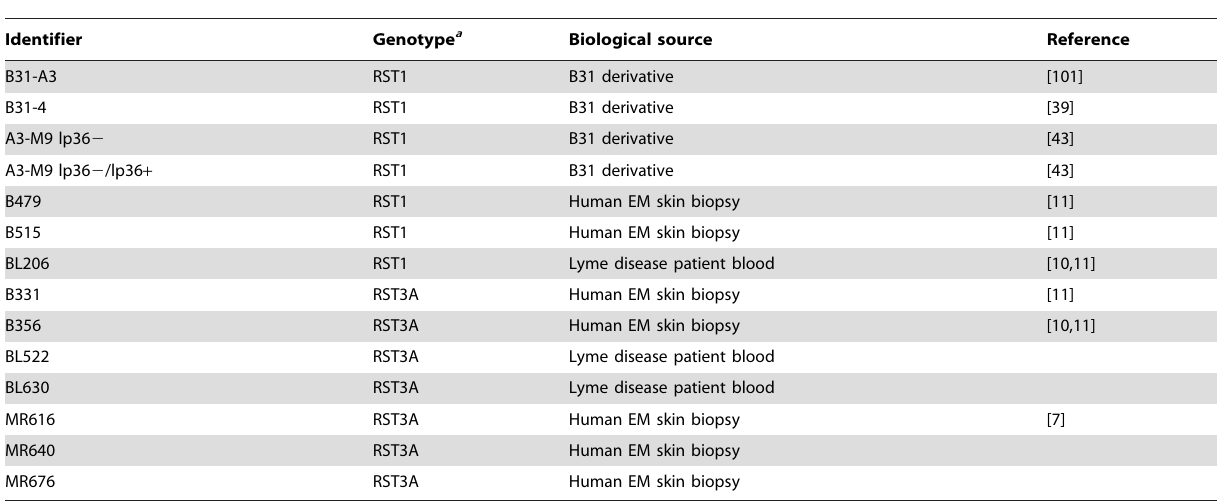
Table 1. B. burgdorferi clinical isolates and strains used in this study.